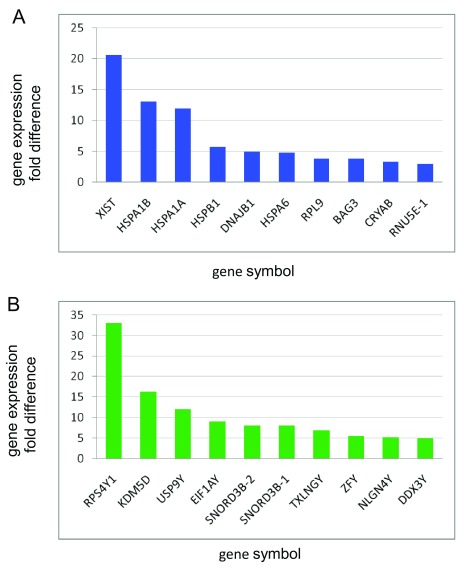
Sex differences in gene expression.(
A) Top differentially expressed genes in the frontal white matter of
APOE4-positive females and (
B) representative top genes differentially expressed in
APOE4-positive males. X-axis, gene symbol; Y-axis, fold difference values.